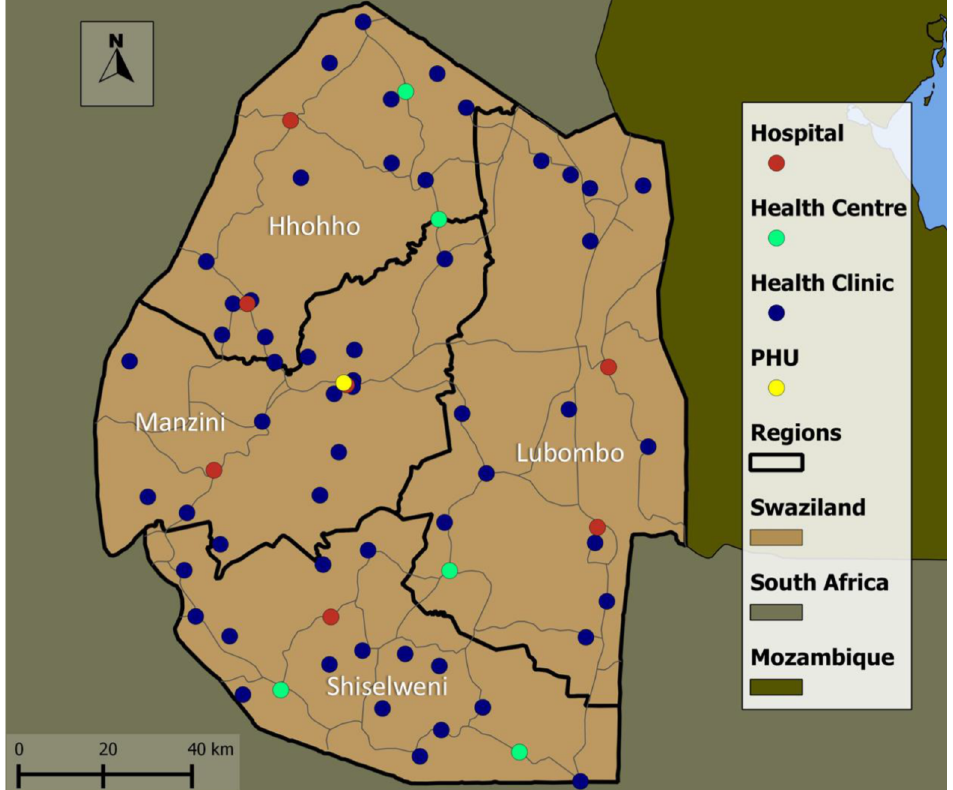
Fig 2. Distribution of 69 HIV care facilities to which eligible SHIMS and SOKA clients were referred at HIV diagnosis, by class of facility.